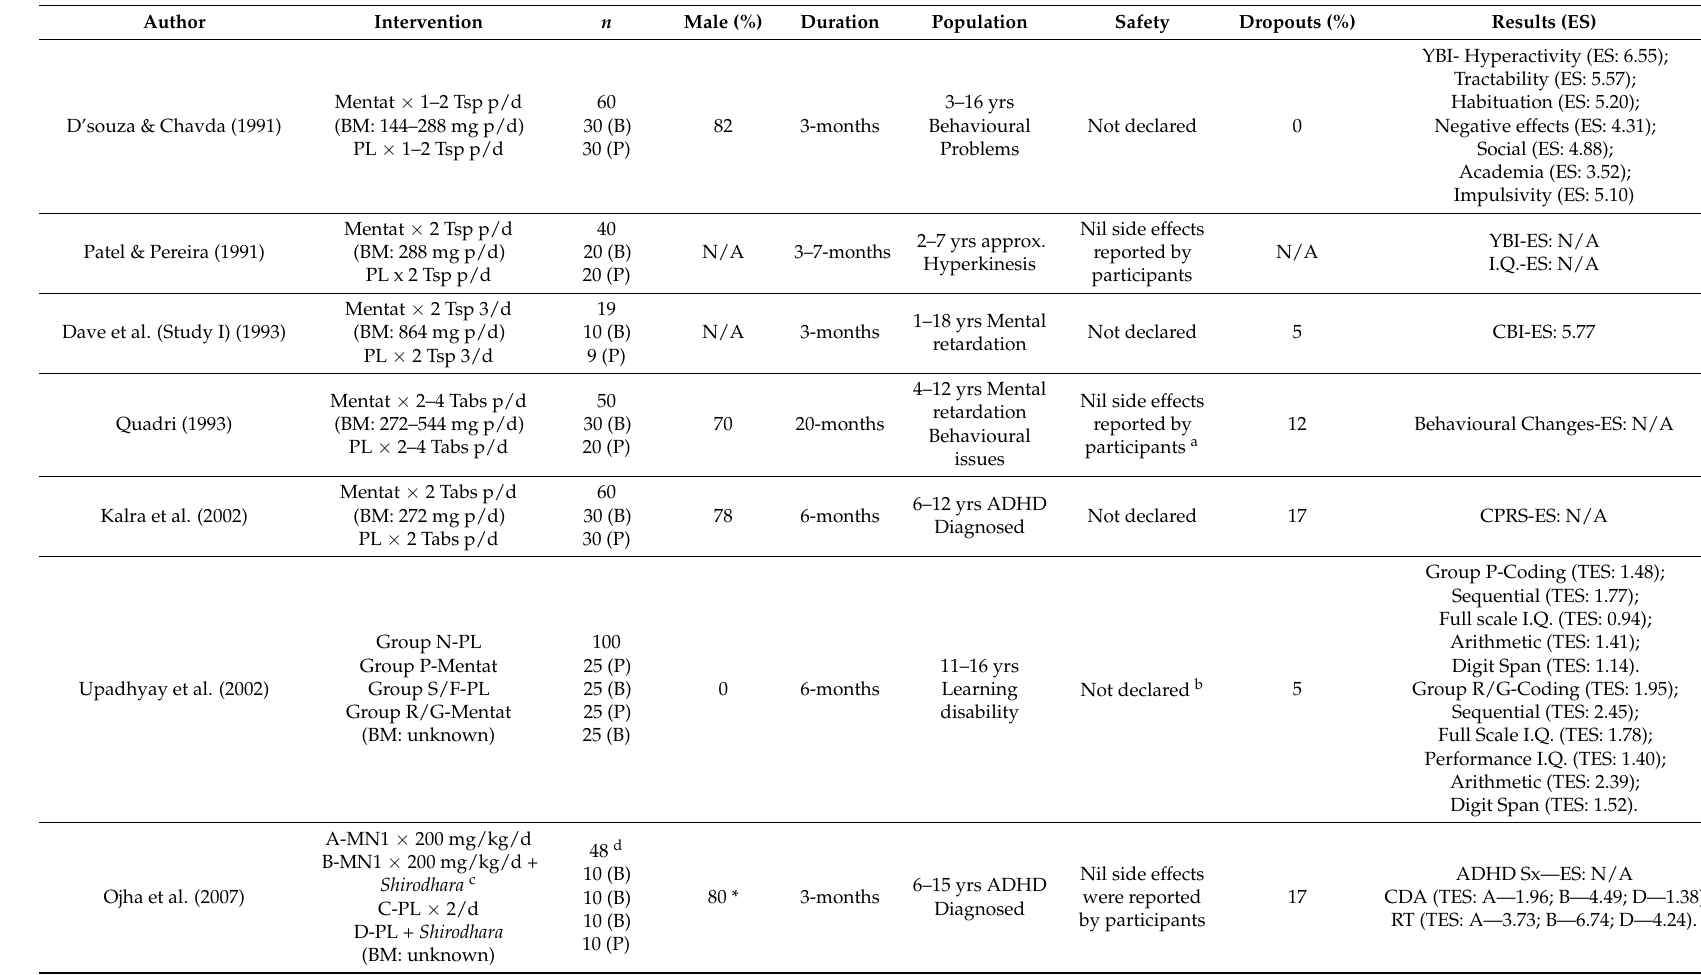
Table 2. Poly-herbal formula studies in child and adolescent clinical and non-clinical